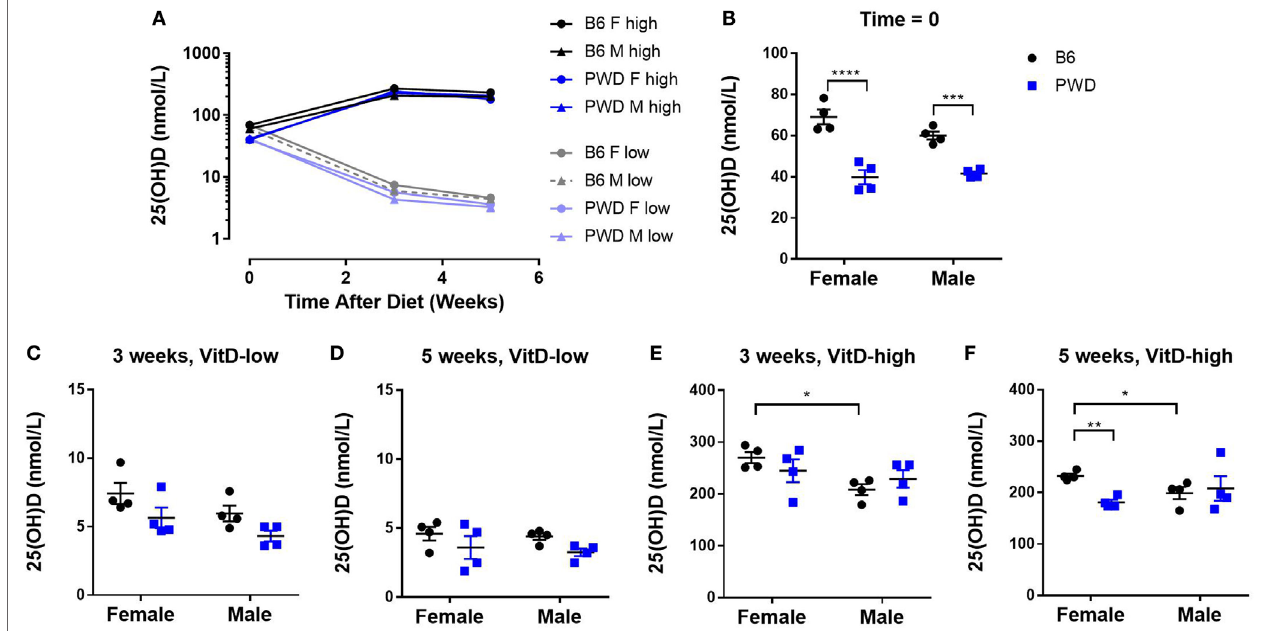
FigUre 1 | Manipulation of dietary vitamin D3 (VitD) results in robust changes in systemic VitD levels that are sex- and genotype dependent. Female and male B6 and PWD mice ( N = 4 for each sex/strain combination) were assigned to VitD-high and VitD-low diets at 3 weeks of age. Serum samples were collected at the outset (Time = 0), and at 3 and 5 weeks post-treatment. 25(OH)D levels were measured by enzyme-linked immunoassay (see Materials and Methods). An overview of kinetic data is shown in (a) , followed by comparisons at individual time points in (B–F) , segregated by diet. The significance of the observed differences in (B–F) was assessed by two-way ANOVA, with Holm–Sidak’s post hoc comparisons: B6 vs. PWD (within sex), and female vs. male (within strain). Symbols indicate a significant difference between the indicated groups, as follows: * p < 0.05; ** p < 0.01; *** p < 0.001; **** p <